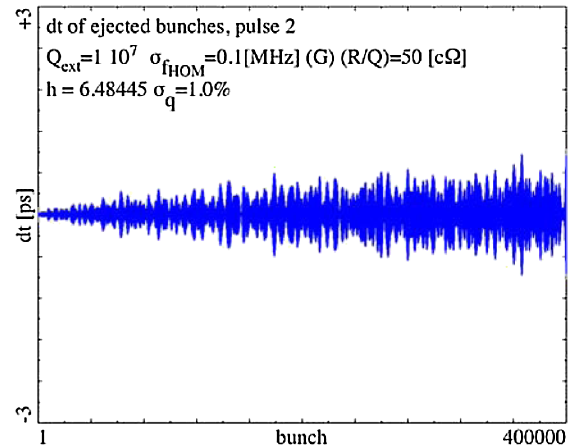
FIG. 77. (Color) Cavity voltages after 2nd pulse; no significant pulse-to-pulse difference since at Q ext ¼ 10 7 there is ‘‘no’’ remaining field from the previous pulse.